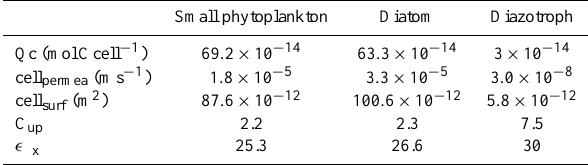
Table 1. Parameters used in the parameterization of (cid:15) p for the im- plementation following Keller and Morel (1999). The values for small phytoplankton are based on E. huxleyi , the value for diatoms are based on P. tricornumtum , and the values for diatoms are based on Synechococcus sp. (Keller and Morel, 1999; Popp et al., 1998). Small